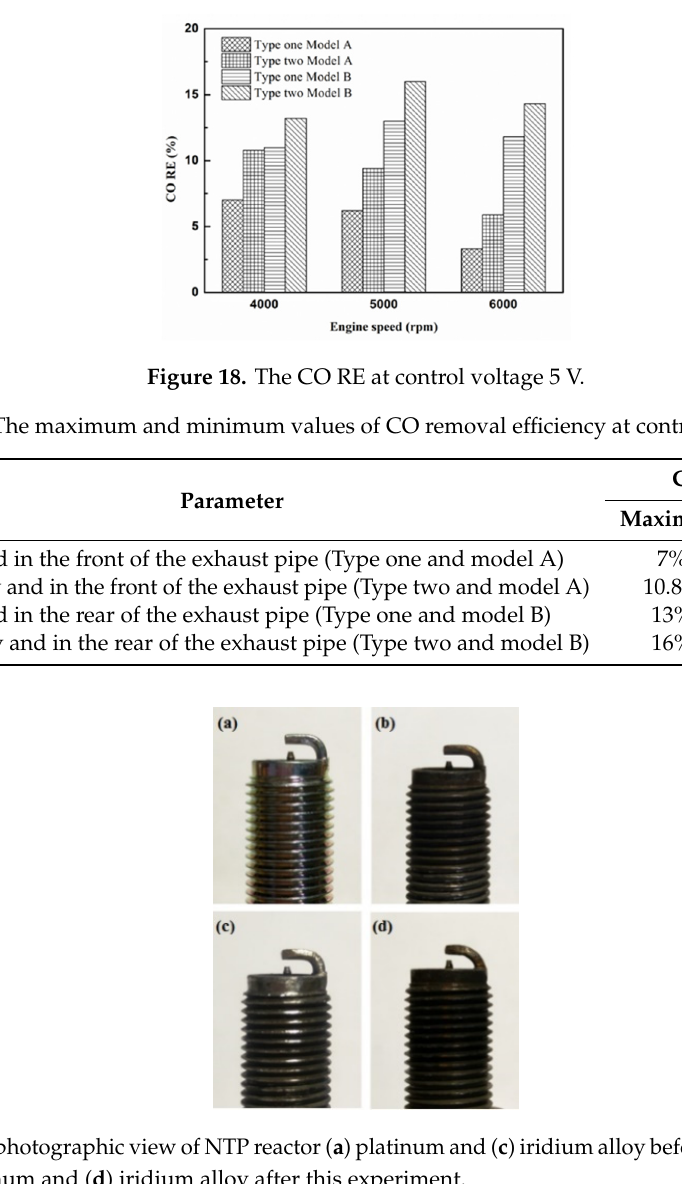
Figure 17. The CO ( a ) emission values and ( b ) RE of control voltage 5 V using iridium alloy.